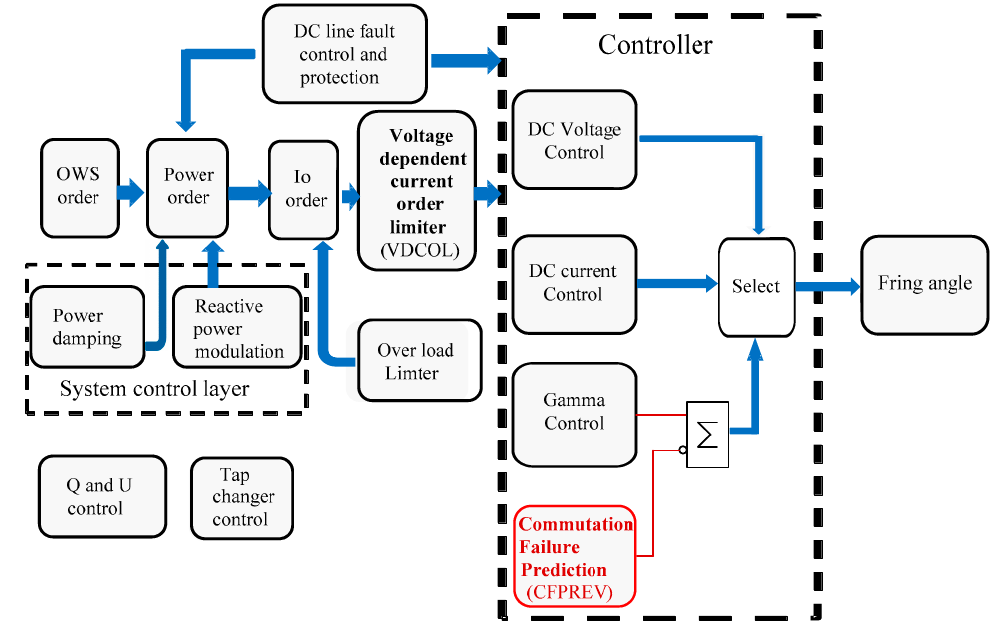
Figure 1. Structure of the TianZhong ± 800 kV ultra-high voltage direct current (HVDC) control system.